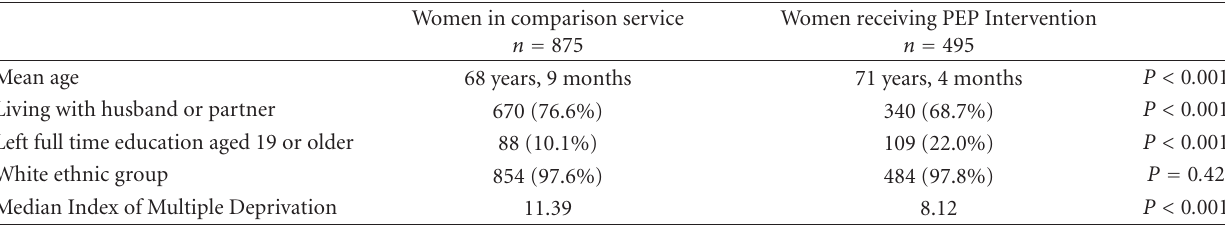
Table 1: Characteristics of women participating in the evaluation.